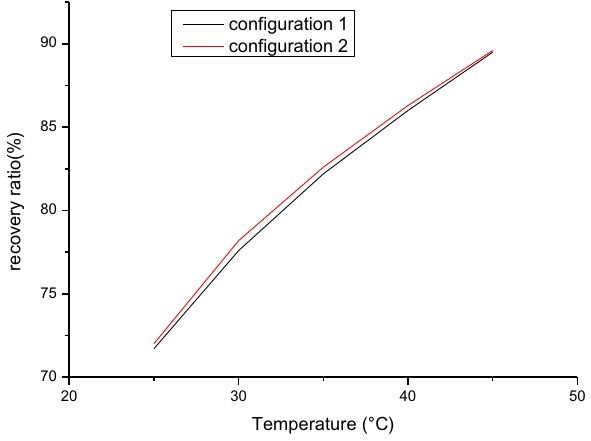
Fig. 16 comparison between conf a and conf b on TH removal % at